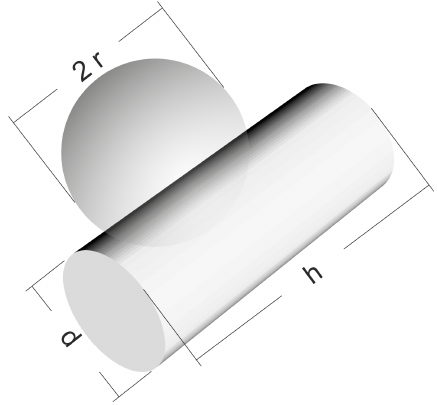
Figure 1. Nomenclature used for cylindrical ice particles.